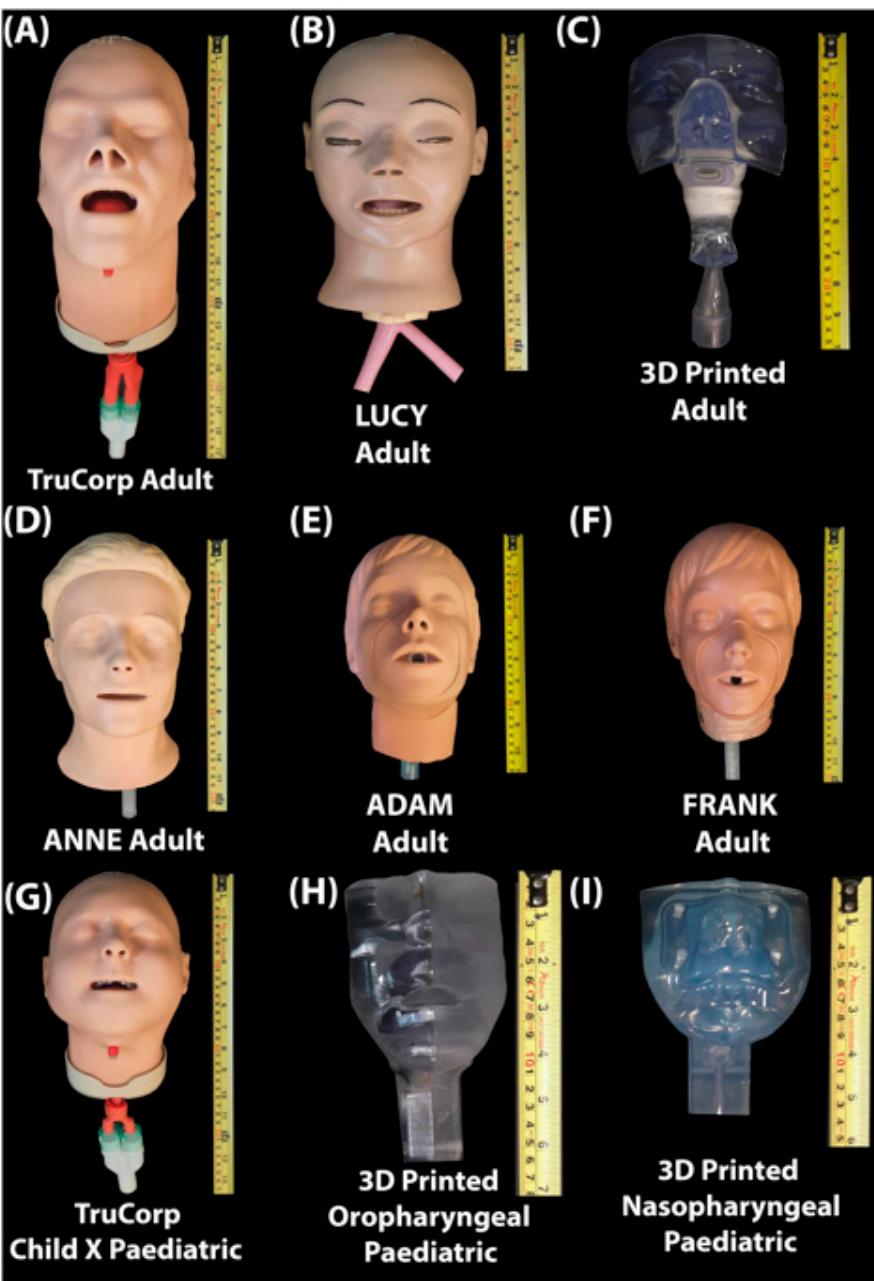
Figure 1. (A ) TruCorp AirSim Advance X (AA91100X, TruCorp ® , Craigavon, Ireland); ( B ) LUCY (Life/form ® Adult Airway Management Trainer, Head Only, SKU: LF03603, Nasco Healthcare, Saugerties, NY, USA); ( C ) 3D Printed anatomically correct head model generated from an individual CT scan; ( D ) ANNE (Resusci Anne ® QCPR, Laerdal medical, Stavanger, Norway); ( E ) FRANK (Model HSM-A 1550, Michigan Instruments, Kentwood, MI, USA); ( F ) ADAM (Adult #2000, Simulaids, INC, Saugerties, NY, USA); ( G ) TruCorp AirSim Child X (AC 10006X, TruCorp ® , Craigavon, Ireland); ( H ) 3D Printed anatomically correct oropharyngeal (Male 5 years) generated from an individual CT scan; ( I ) 3D printed anatomically correct nasopharyngeal (1688) head model generated from an individual CT scan. The 3D printed paediatric nasopharyngeal and oropharyngeal head models also con-